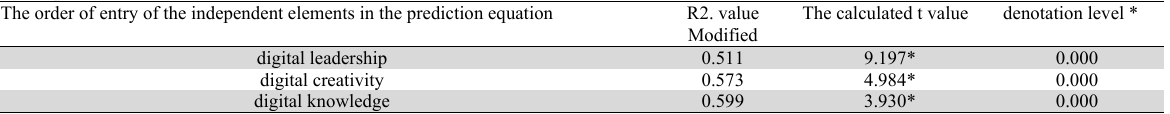
Results of Stepwise Multiple Regression to predict digital supply chains through the dimensions of digital Entrepreneurship as independent variables The order of entry of the independent elements in the prediction